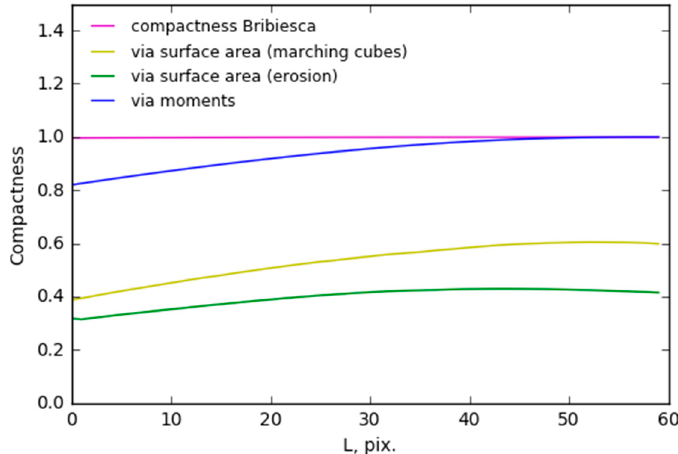
Figure 10. Compactness when the shape of the body changes from the hemisphere to the sphere.